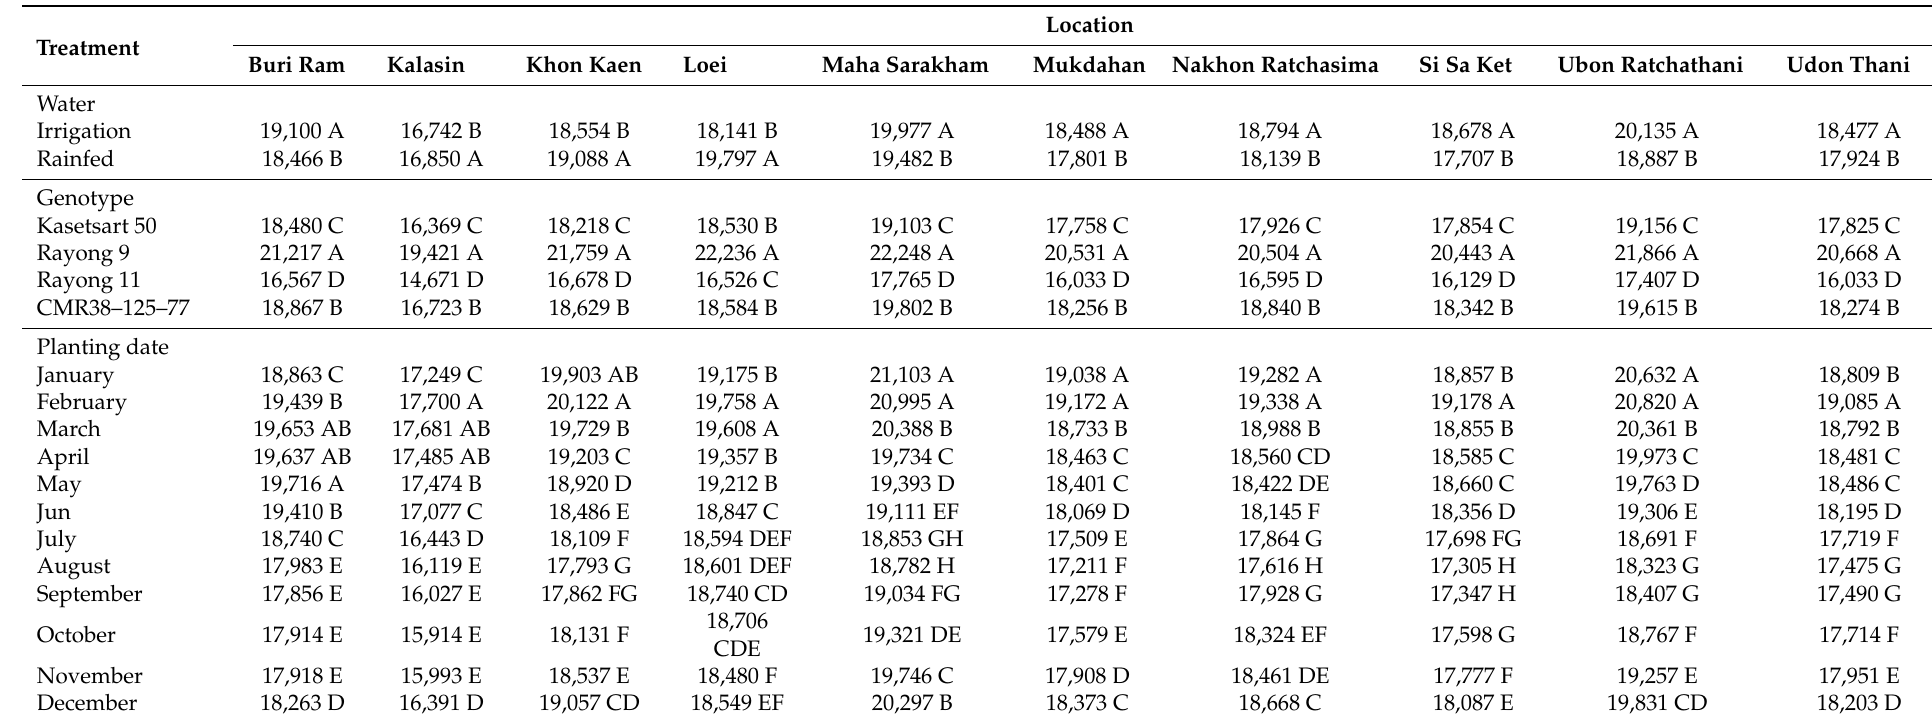
Table 4. Simulated storage root dry weight (kg ha − 1 ) for different treatment scenarios over 30 years (from 1988–2018) in ten locations in northeast Thailand.